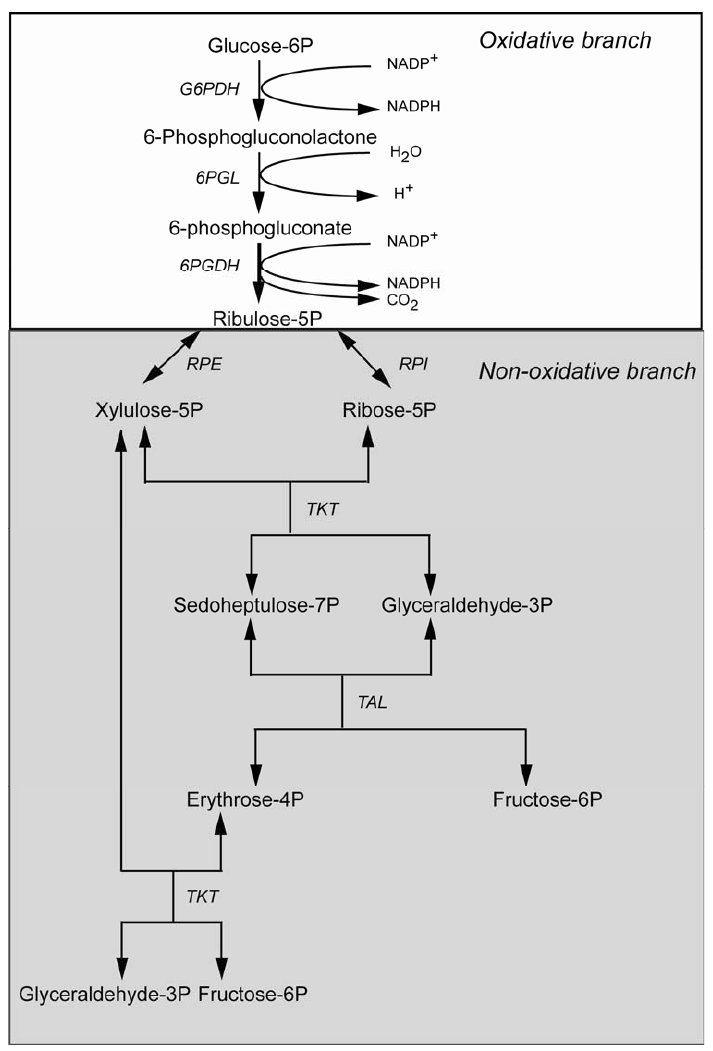
Fig. 1 – Scheme of the pentose phosphate pathway. The enzymes involved are glu- cose 6-phosphate dehydrogenase (G6PDH), 6-phosphogluconolactonase (6-PGL), 6- phosphogluconate dehydrogenase (6PGDH), ribose 5-phosphate isomerase (RPI), ribu- lose 5-phosphate epimerase (RPE), transaldolase (TAL) and transketolase